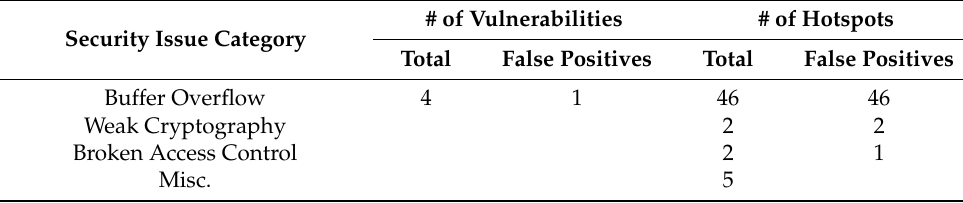
Table 15. Number of security issues of different categories in the Boa